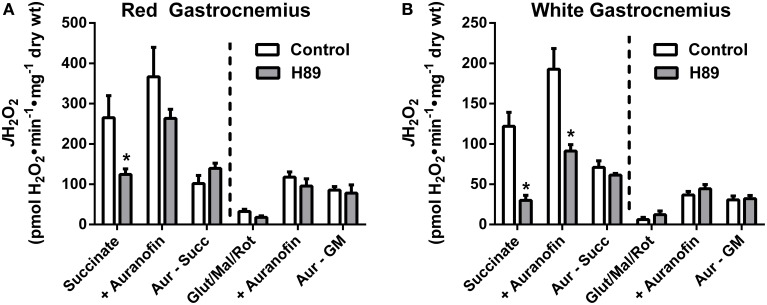
PKA signaling regulates reverse, but not forward electron flow, through complex I in mouse PmFBs. Mitochondrial H2O2 emitting potential (mOEP) was measured in RG (A) and WG (B) with succinate (left) or glutamate/malate/rotenone (right) and in the absence (white bars) or presence (gray bars) of 10 μM H89 in the assay media. Auranofin (1 μM) was added to specifically measure H2O2 production, and an “oxidant scavenging index” was determined based on the increase in mOEP following addition of auranofin. N = 4–8/condition. * denotes p < 0.05 compared to Control.